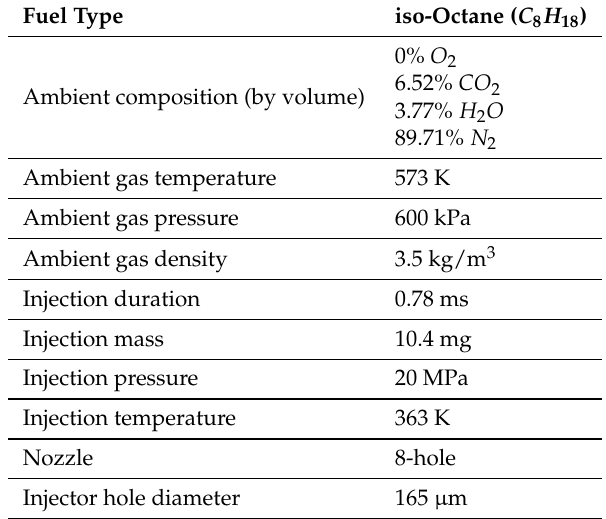
Table 1. “ Spray G ” baseline characteristics and operating